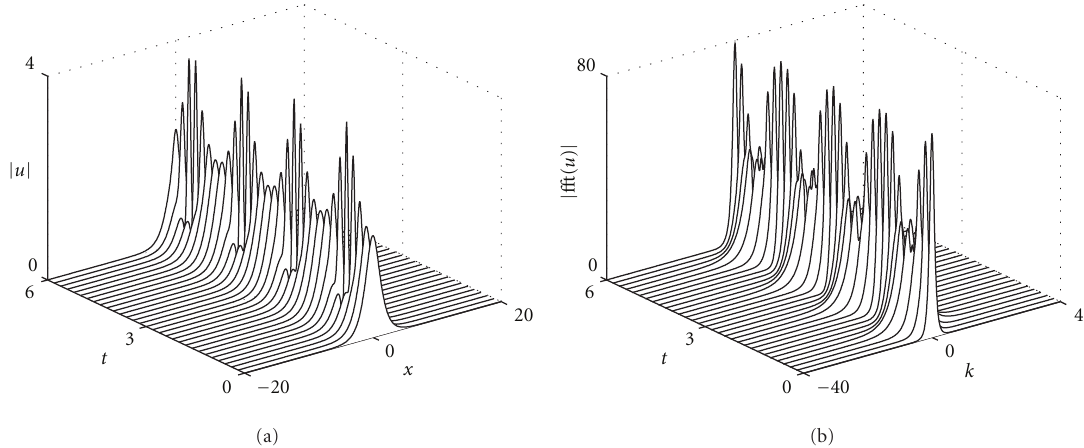
Figure 2: Evolution of the N = 2 soliton. Here a periodic dynamics is observed, and approximately 200 Fourier modes are required to model accurately the